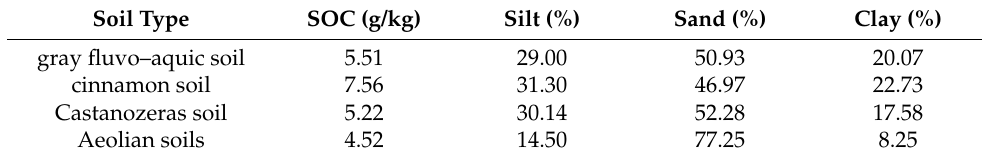
Figure A1. The relationship of slope and soil organic carbon (SOC). Table A1. The mean value of soil organic carbon (SOC) and soil texture in different soil types.